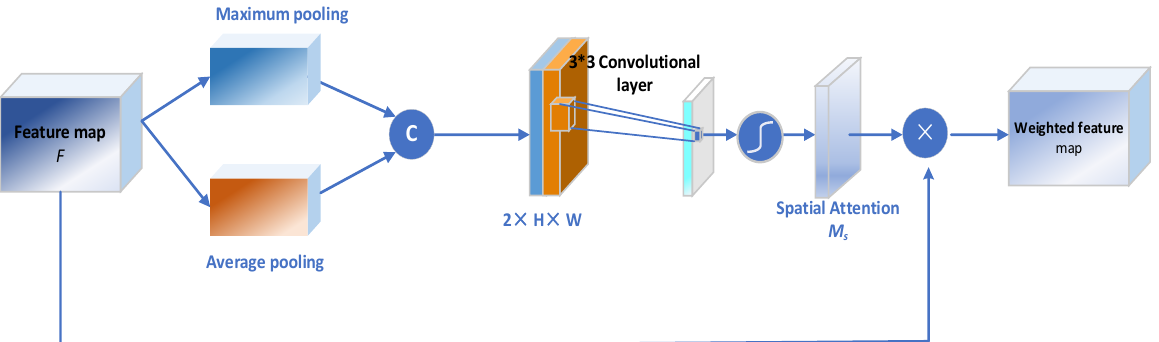
Figure 15. Diagram of spatial attention sub-module. As illustrated, the spatial sub-module utilizes max-pooling outputs and average-pooling outputs that are pooled along the channel axis and forwarded to a convolution layer.